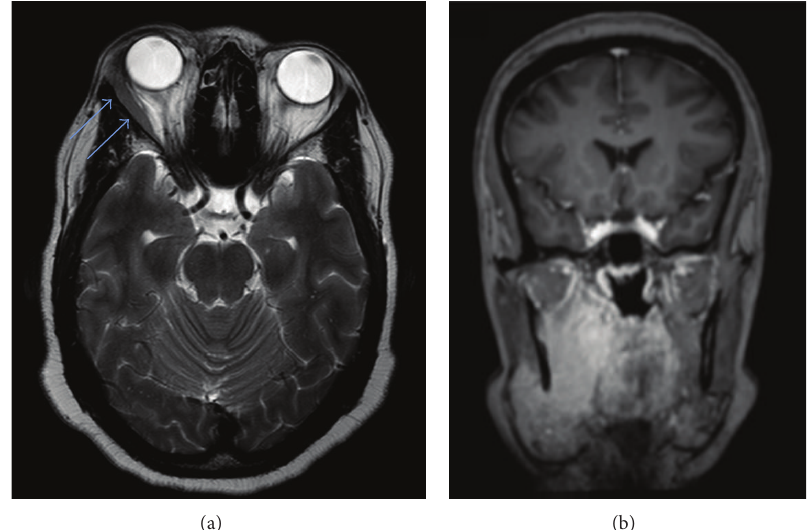
Figure6: Headandneckmagneticresonanceimaging :axialT2MRIrevealedenlargementofthelateralrectusmuscleofrightorbit(arrows)(a). A coronal contrast-enhanced T1 MRI showed an infiltrating lesion centered in the right masticator space extending into the submandibular space involving the submandibular gland. Note the avid gadolinium enhancement pattern of the lesion and its ill-defined margins (b).